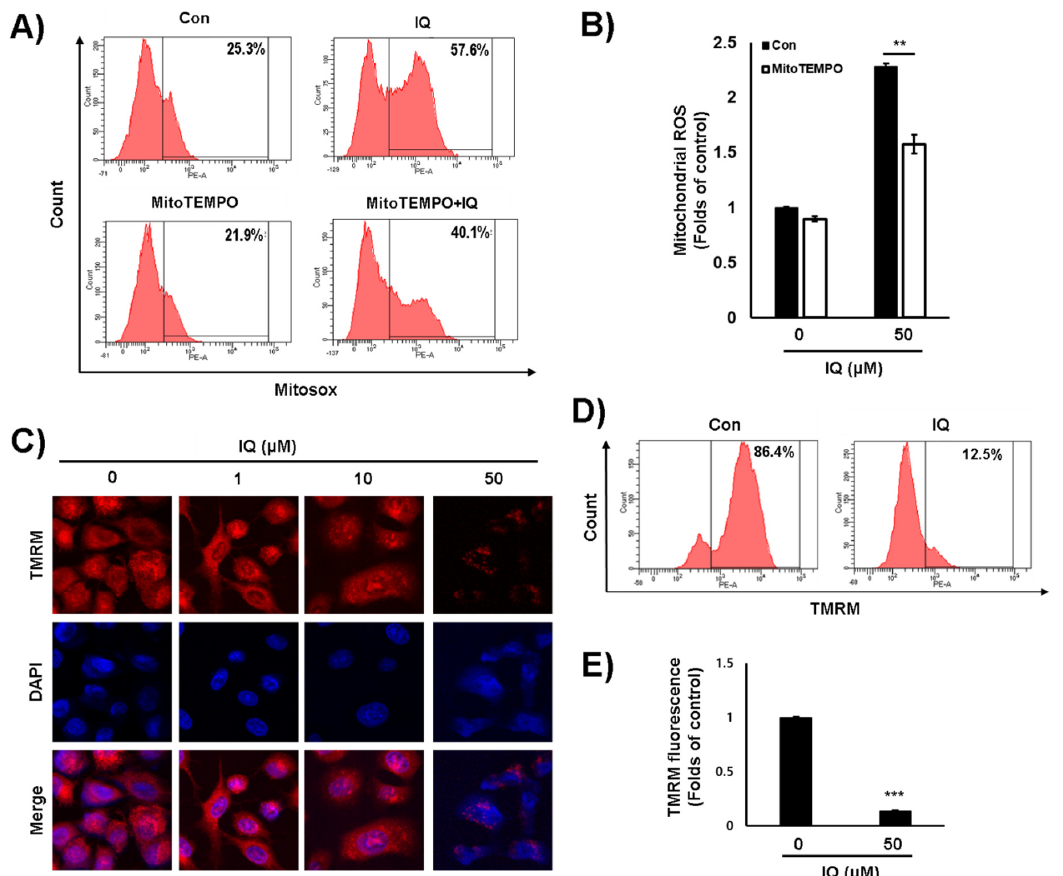
Figure 4. IQ increased mitochondrial ROS and mitochondrial damage in A549 cells. ( A , B ) The A549 cells were pretreated with MitoTEMPO for 1 h at 50 µ M and treated with IQ for 12 h at 50 µ M. ( A ) After the cells were stained with MitoSOX ™ Red, the fluorescence was analyzed by FACS. ( B ) The MTT assay was performed. The cells were treated with IQ for 12 h and then, stained with TMRM. The fluorescence intensity was analyzed via confocal microscopy and FACS ( C , D ). ( E ) The bar graph from three independent experiments ( D ) is shown, and the values represent the mean ± SD. The experiments of panel B and E were performed at least three times, and data are shown as the mean ± SD. Statistical analyses were performed using Student’s t -test. **, p < 0.05 and ***, p < 0.001 compared with the control.